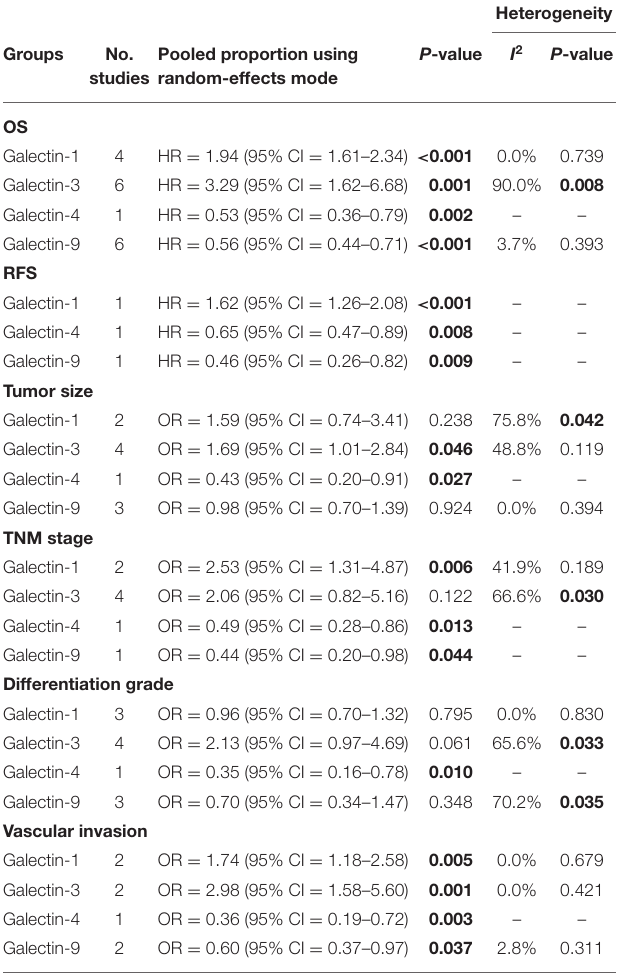
TABLE 2 | Galectins with the prognosis and clinicopathological features of HCC: results of the meta-analyses.